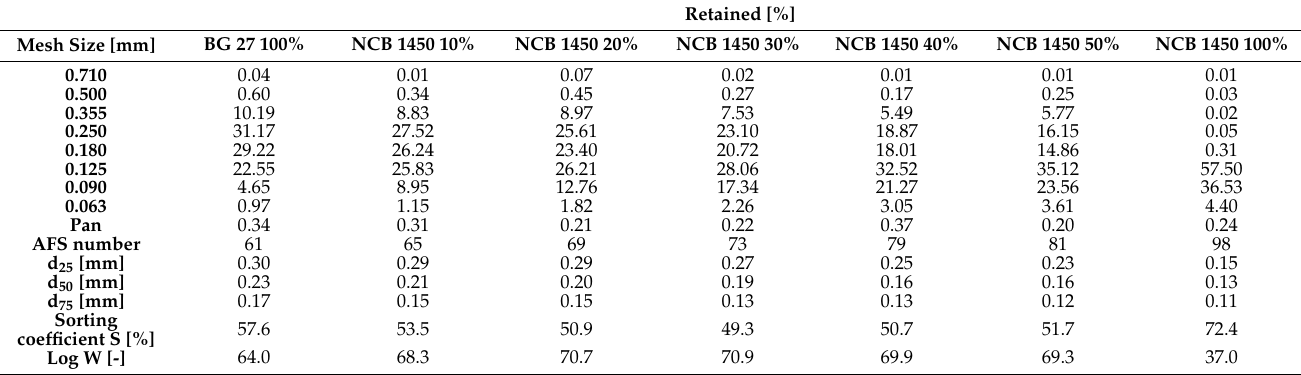
Table 4. Particle size distribution and basic parameters of test sand specimens for NCB